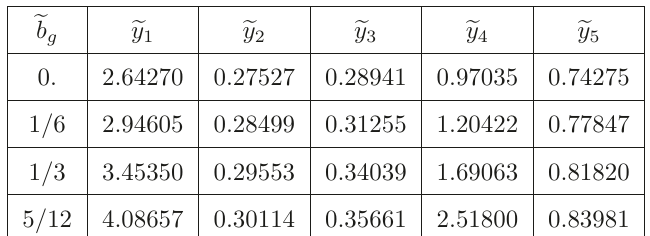
Table 1 . Flat space UVFPs for SO(